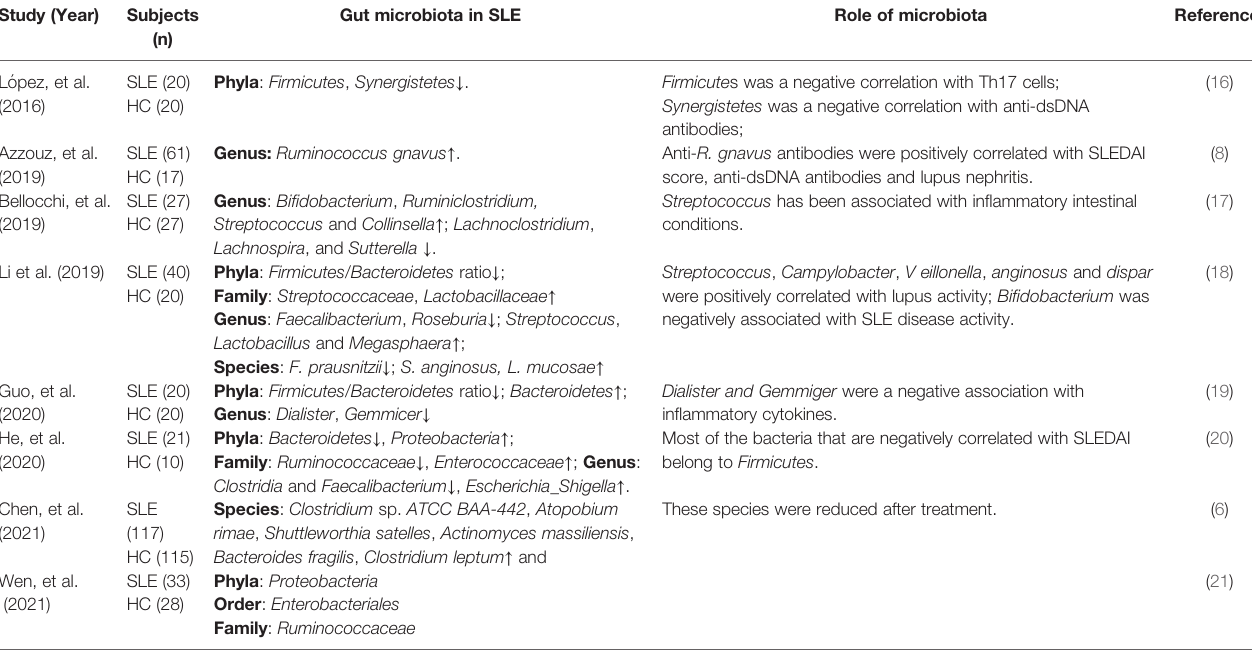
TABLE 1 | Gut microbiota dysbiosis in patients with SLE.